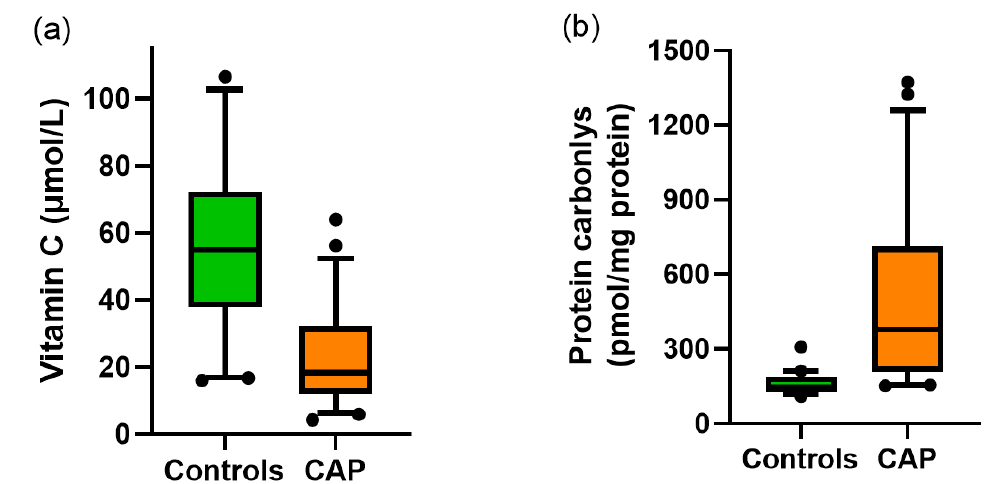
Figure 1. Vitamin C status and protein carbonyl concentrations in the community-acquired pneumonia (CAP) cohort and healthy controls. ( a ) Vitamin C was measured using HPLC with electrochemical detection, p < 0.001, n = 50 for both controls and CAP. ( b ) Protein carbonyls were measured using ELISA; p < 0.001, n = 50 for controls, n = 46 for CAP. Box plots show median with 25th and 75th percentiles as boundaries, and whiskers are the 5th and 95th percentiles, with symbols indicating outlying data points.